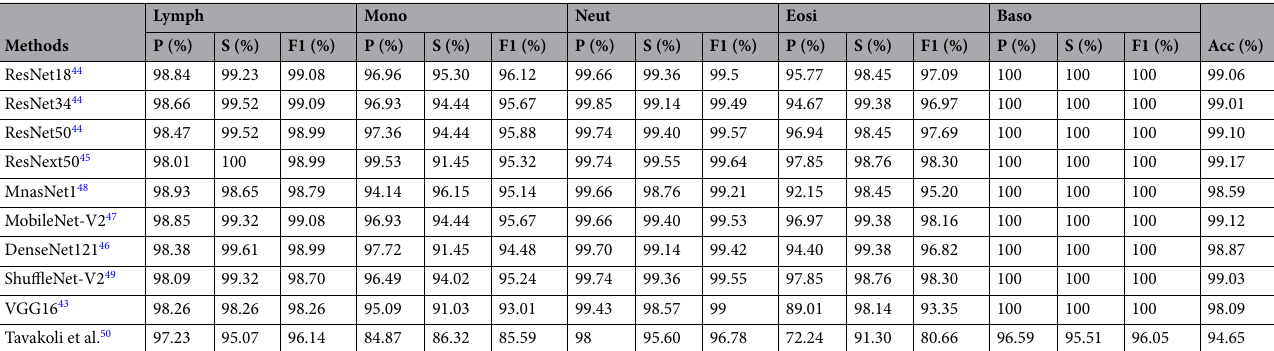
Table 8. The results of different pre-trained models as well as Tavakoli et al. 50 on the test-A